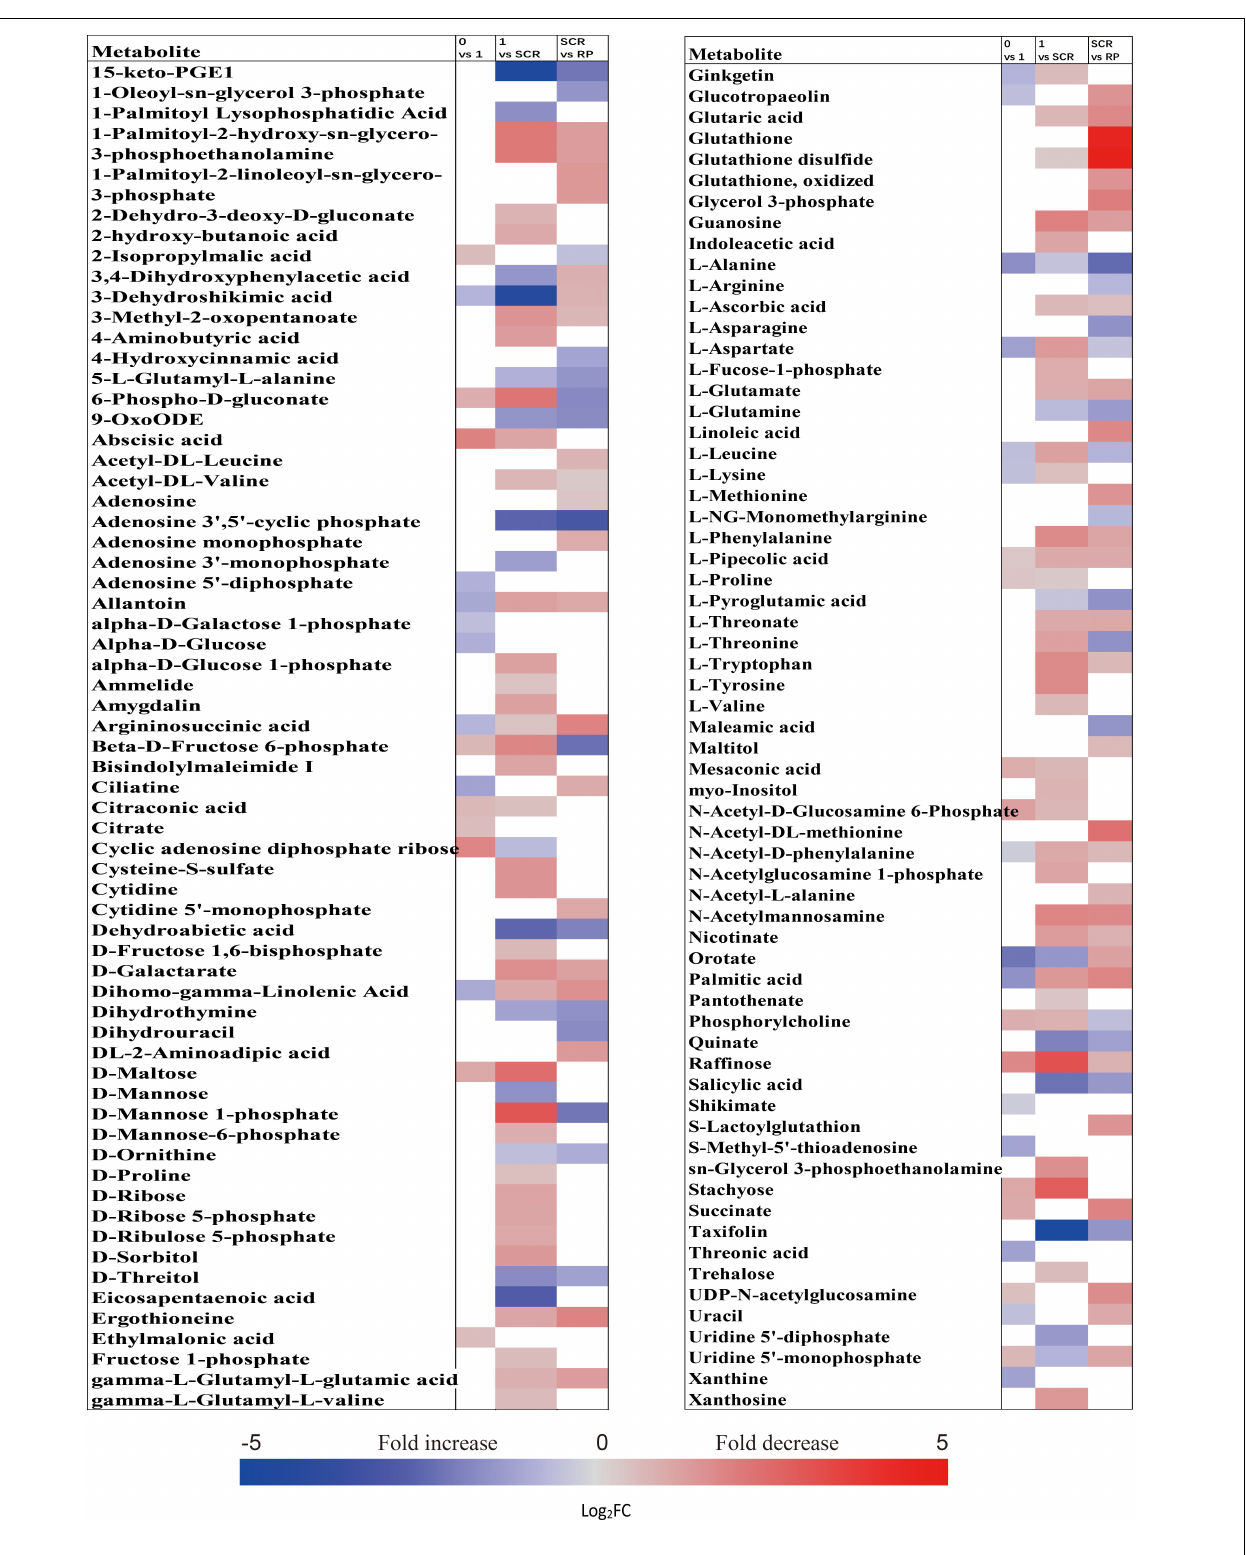
FIGURE 5 | Fold change in the relative contents of important metabolites with VIP value > 1 and P < 0.05 in the embryos of non-primary physiological dormant seeds between different incubation time points, such as 0 week vs. 1 week, 1 week vs. SCR (seed coat rupture), and SCR vs. RP (radicle protrusion). Fold changes are represented as a heat map. White coloring indicates no significant change. VIP, variable importance in the projection.